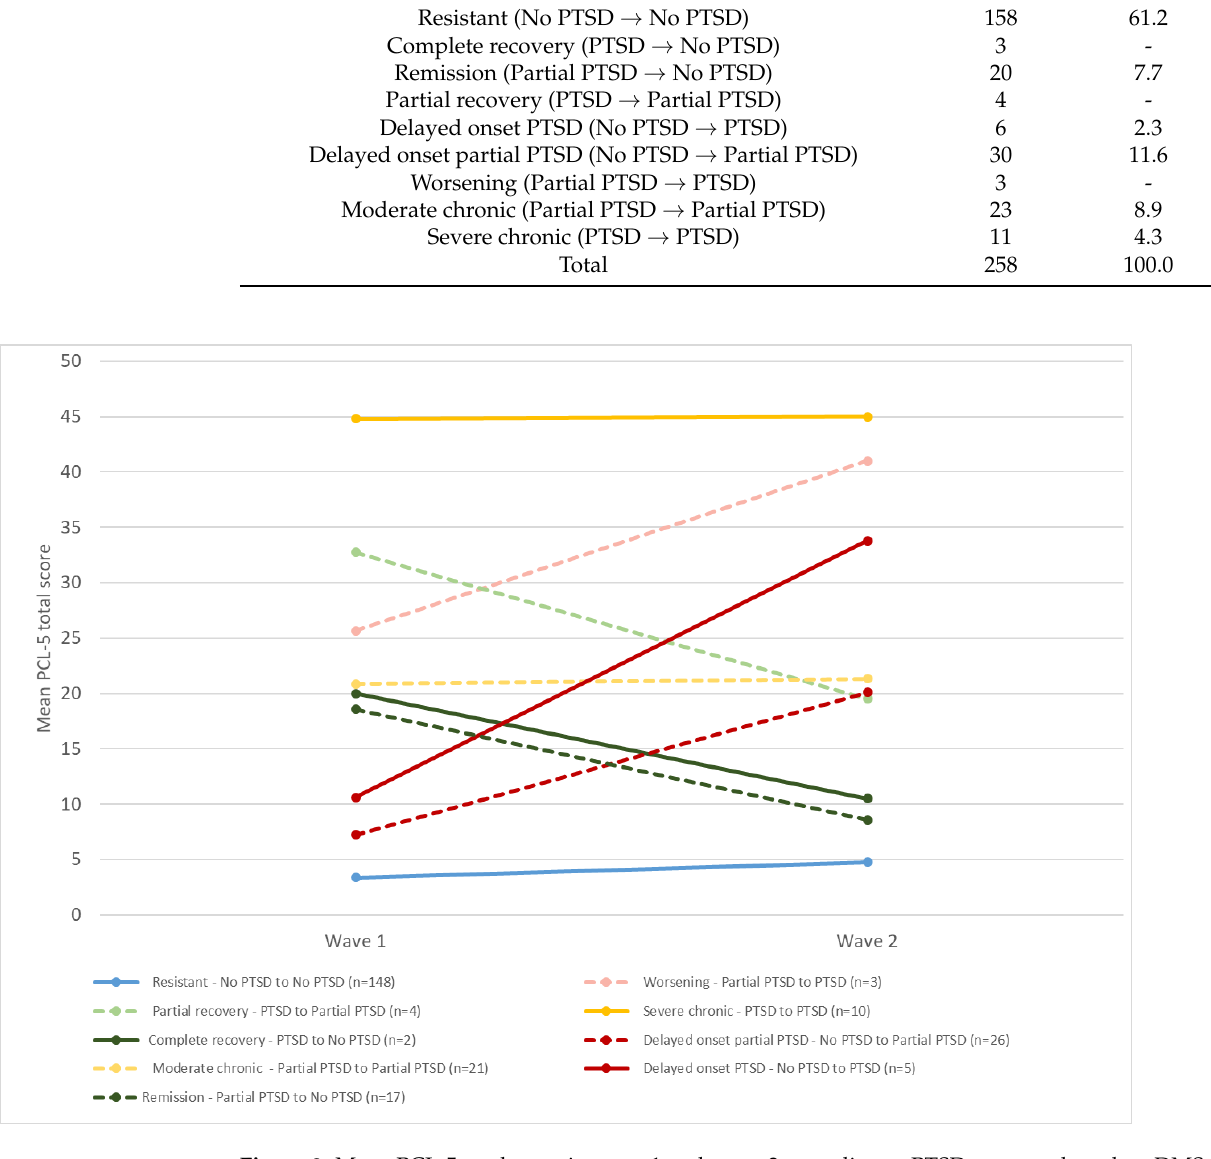
Figure 2. Mean PCL-5 total score in wave 1 and wave 2 according to PTSD category based on DMS-5 criteria, ESPA 13 November survey (n = 238). Table 2. Prevalence of trajectories of PTSD between wave 1 and wave 2, n=258.